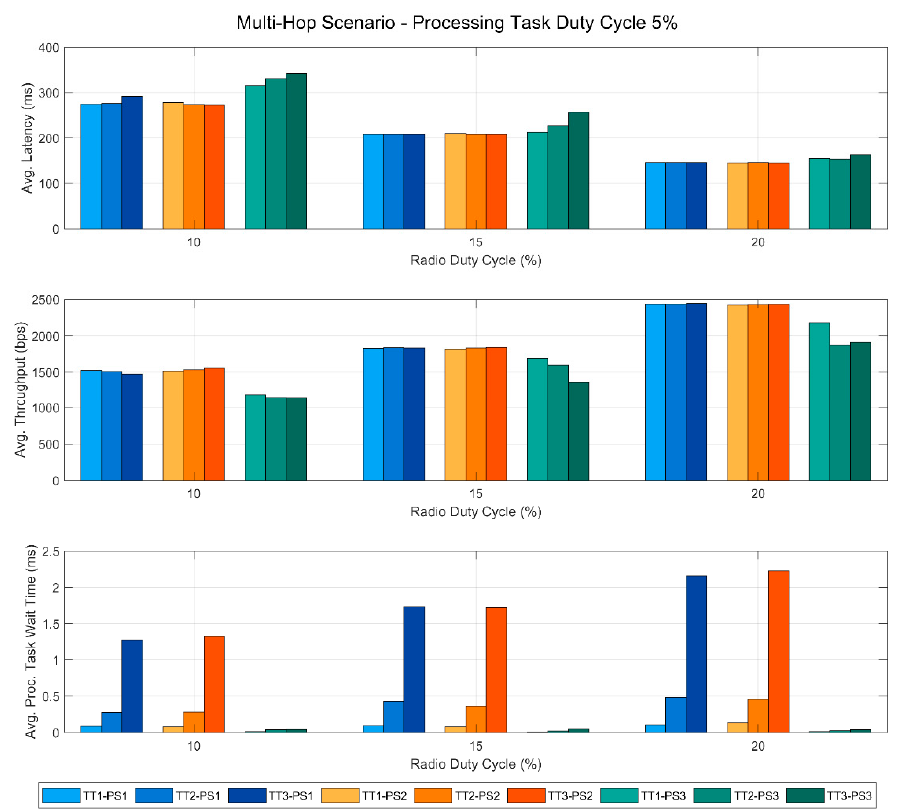
Figure 8. Multi-hop scenario with a fixed Processing Task Duty Cycle of 5%.